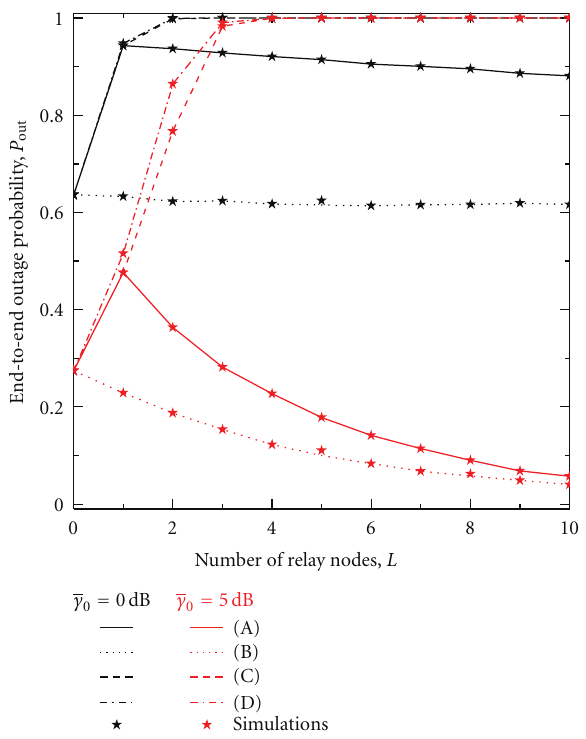
Figure 3: End-to-end OP, P out , versus the number of relay nodes, L , for di ff erent average transmit SNRs over IID Rayleigh fading chan- nels: (A) pure RS, (B) rate-selective RS, (C) repetitive transmission with MRD and (D) repetitive transmission with SD.